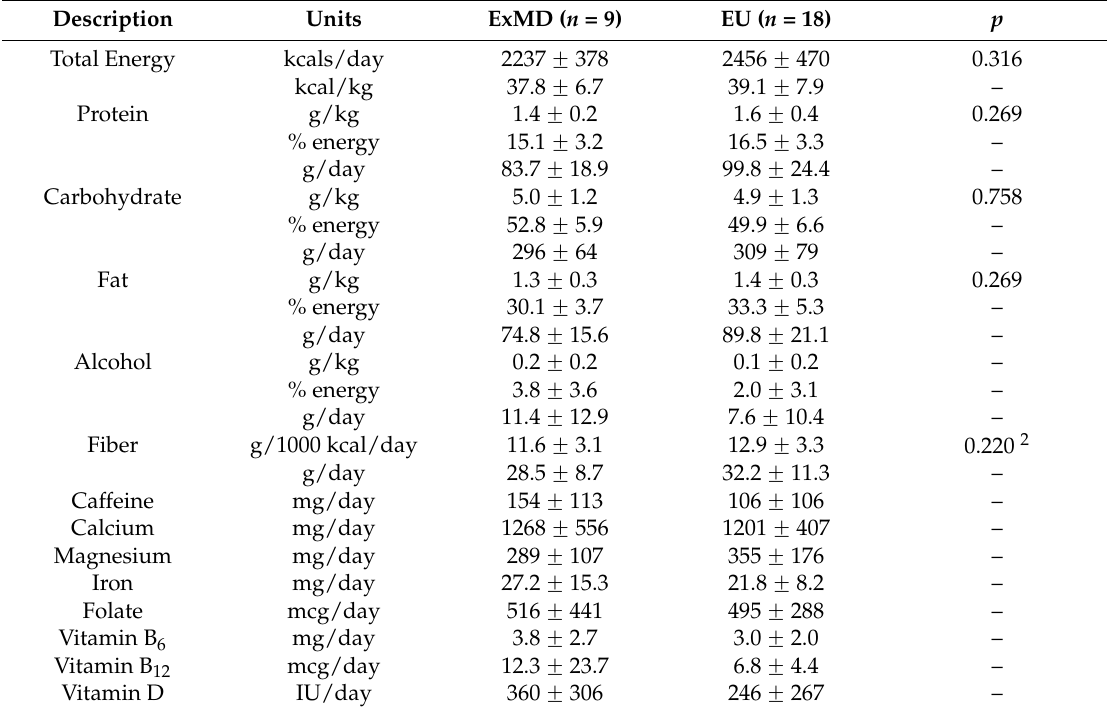
Table 2. Active women classified as Exercise-Associated Menstrual Dysfunction (ExMD) or Eumenorrheic (EU) Active Controls: Energy and Nutrient Intakes from 6 to 7 day Weighed Food Records 1